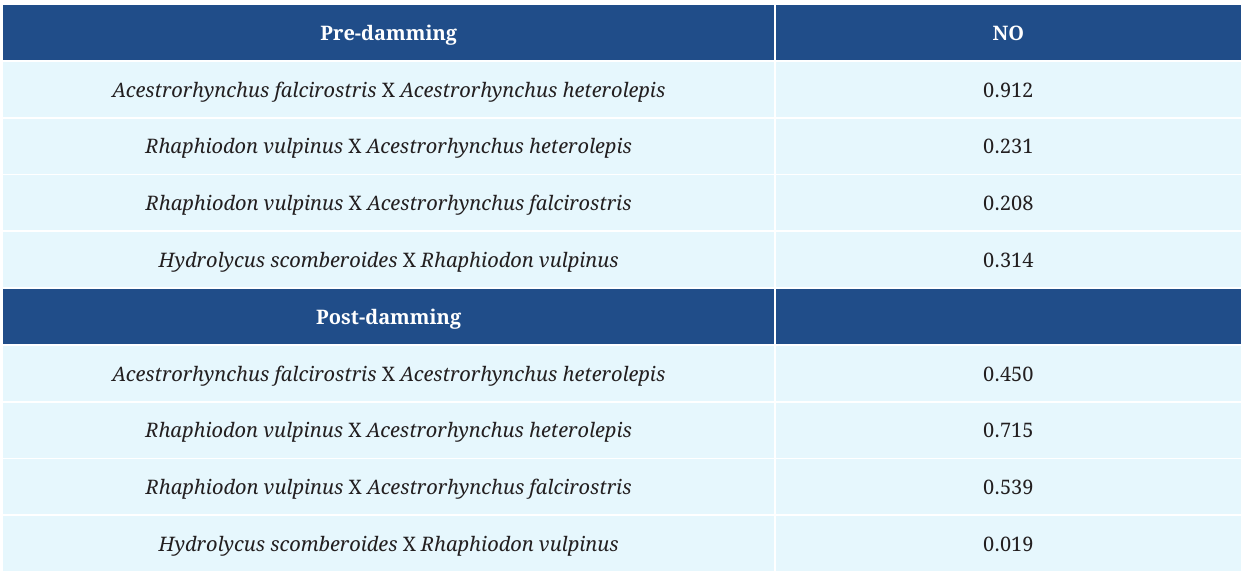
TABLE 4 | Pairwise niche overlap (NO) values using Pianka Index and p-values of niche